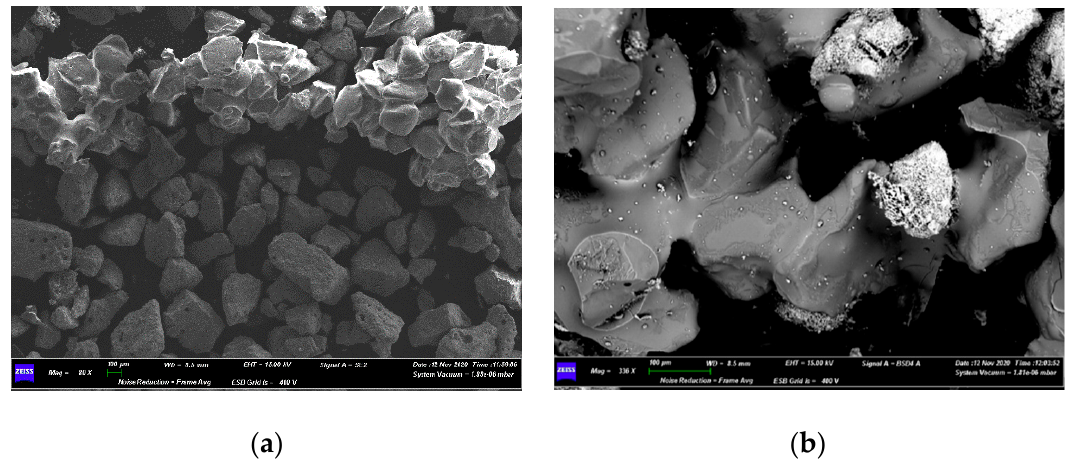
Figure 10. SEM micrographs of bottom of spent sand bed after the last test, magnified at: 80× ( a ); 336× ( b ).